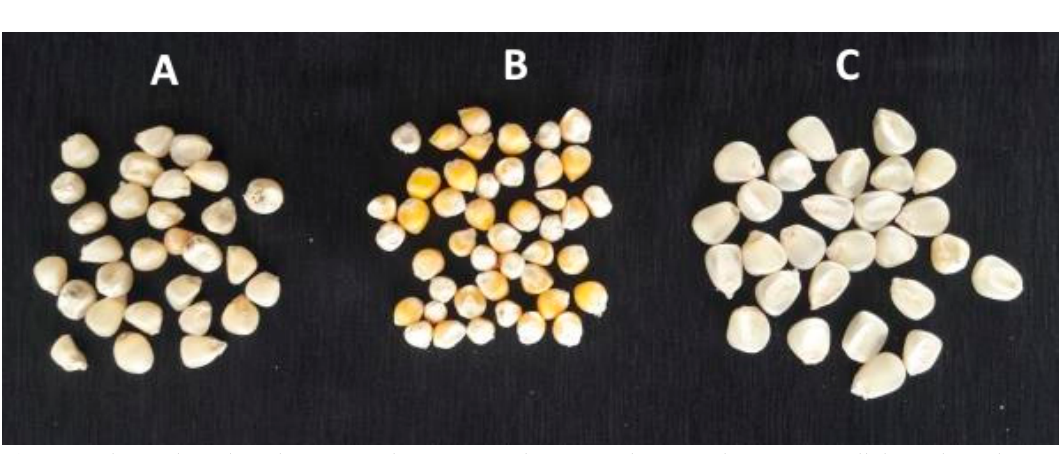
Figure 3. The 3 selected seed types, seed type 1—medium round ( A ), seed type 2—small drop-shaped Figure3. The3selectedseedtypes, seedtype1—mediumround( A ),seedtype2—smalldrop-shaped( B ), ( B ), and seed type 3—flat and large ( C ). and seed type 3—flat and large ( C